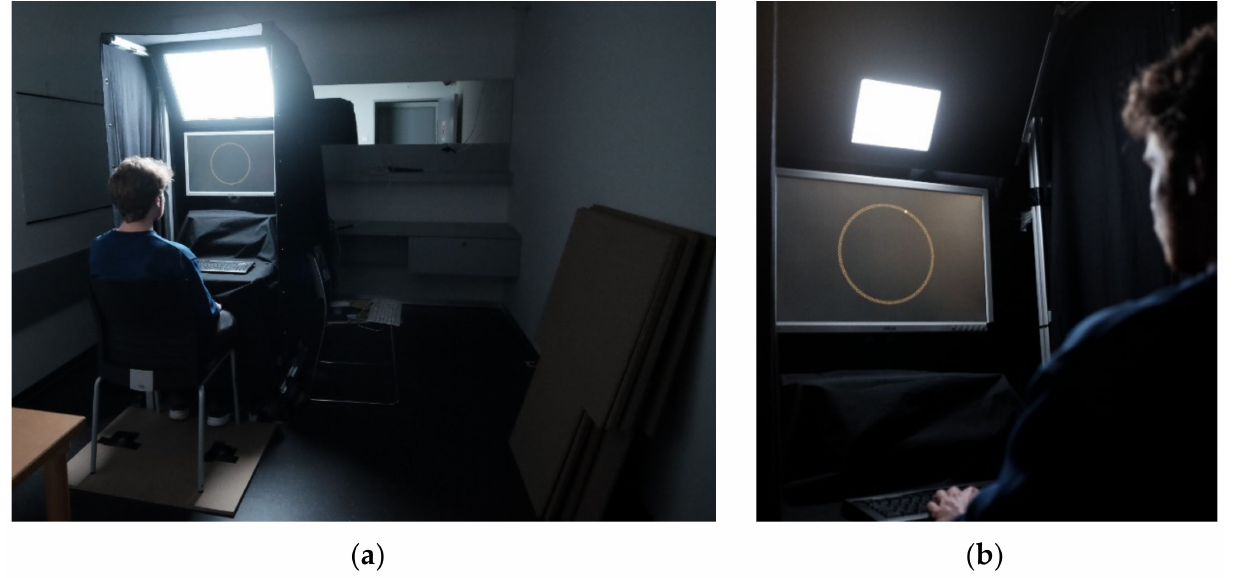
Figure 2. ( a ) Experimental setup in the test condition with the large solid angle; ( b ) subject completing the MWCT in the test condition with the small solid